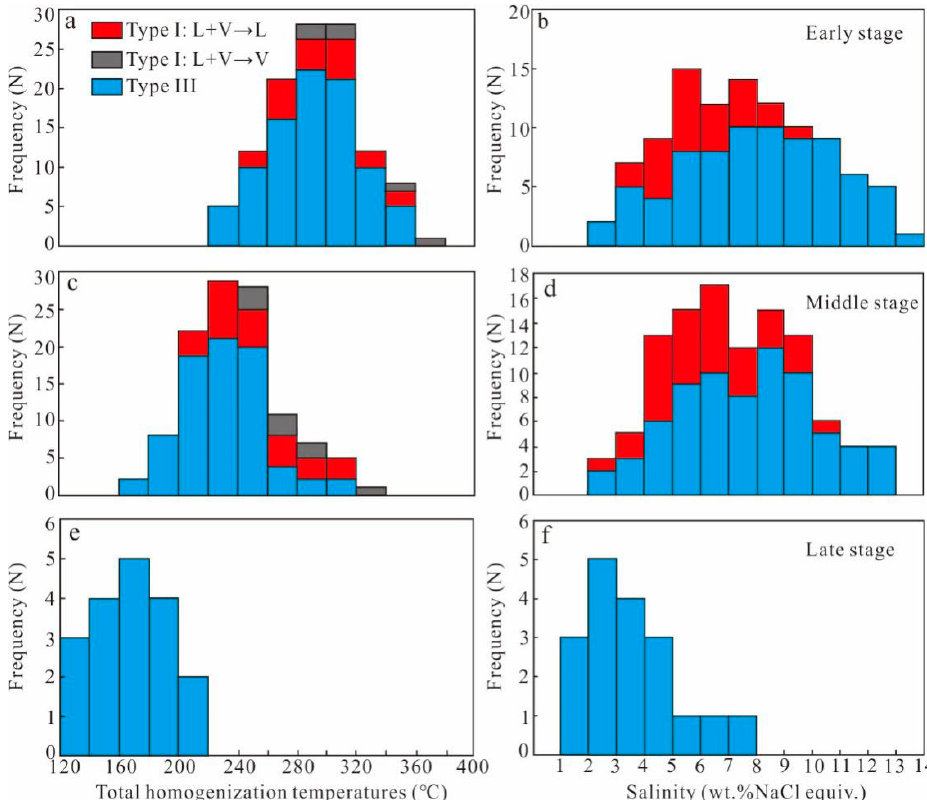
Figure 9. Frequency histograms of total homogenization temperatures (T h ) and salinities of fluid inclusions from different stages of the Liyuan gold deposit. Early stage ( a,b ); middle stage ( c,d ); and late stage ( e,f ).